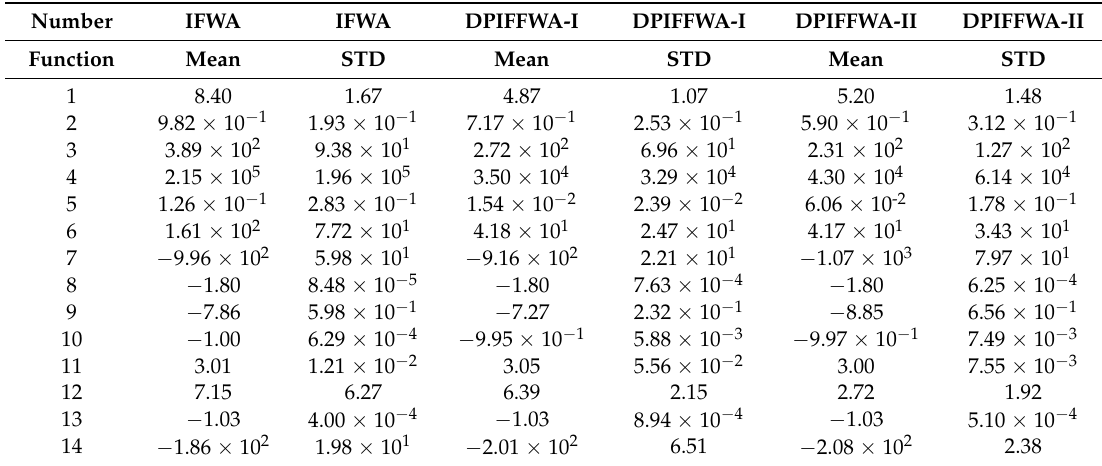
Table 9. Means and standard deviations of the fourteen benchmark functions with SI =